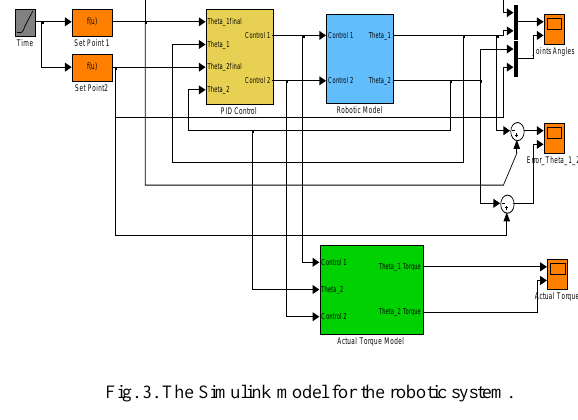
Fig. 3. The Simulink model for the robotic system.